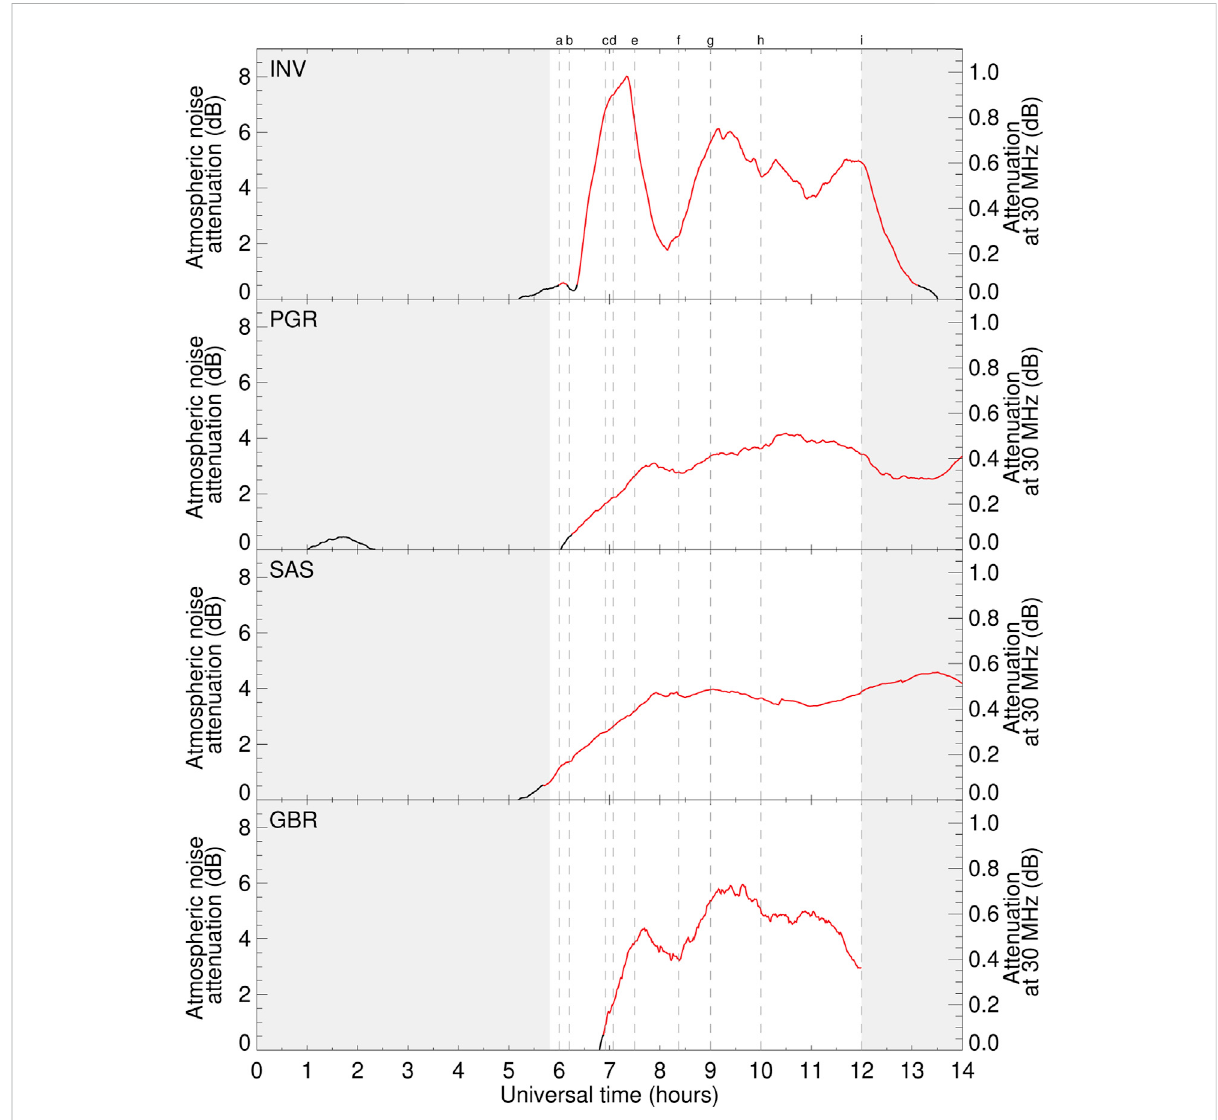
FIGURE 5 Atmospheric noise attenuation (ANA) estimates for the Inuvik (INV), Prince George (PGR), Saskatoon (SAS) and Goose Bay (GBR) SuperDARN radars on 25 October 2019. The left axis shows the ANA values at the native radar operating frequency. The right axis shows the equivalent attenuation at 30 MHz (see text for details). The vertical dashed lines correspond to the time intervals shown in Figure